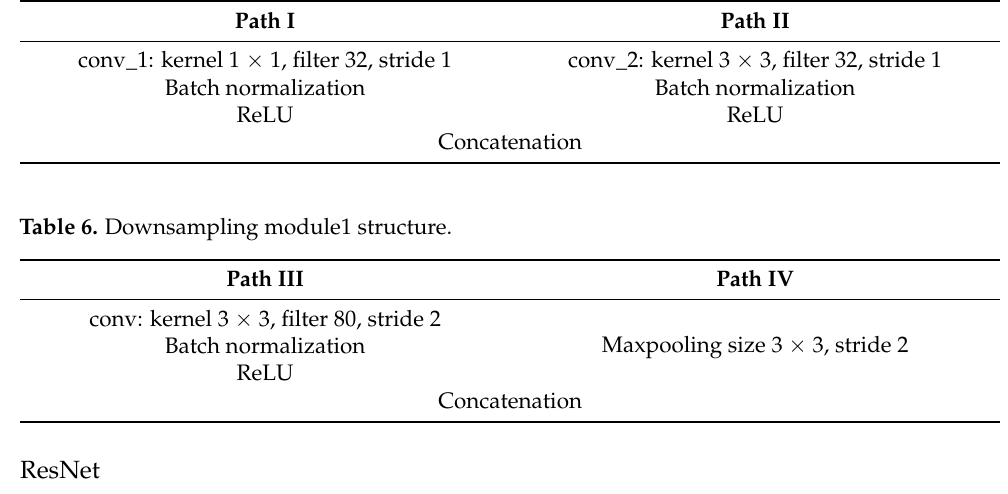
Table 5. Inception module 1a structure.